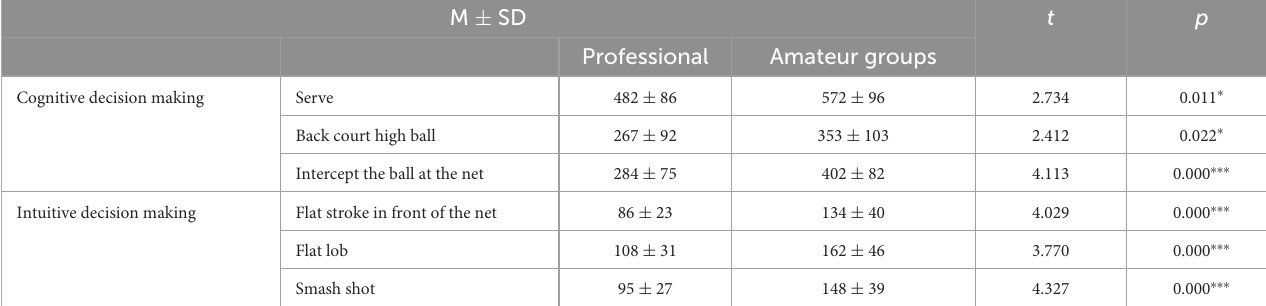
TABLE 2 Average reaction time of the two groups of subjects in different types of decision-making tasks (unit: ms).